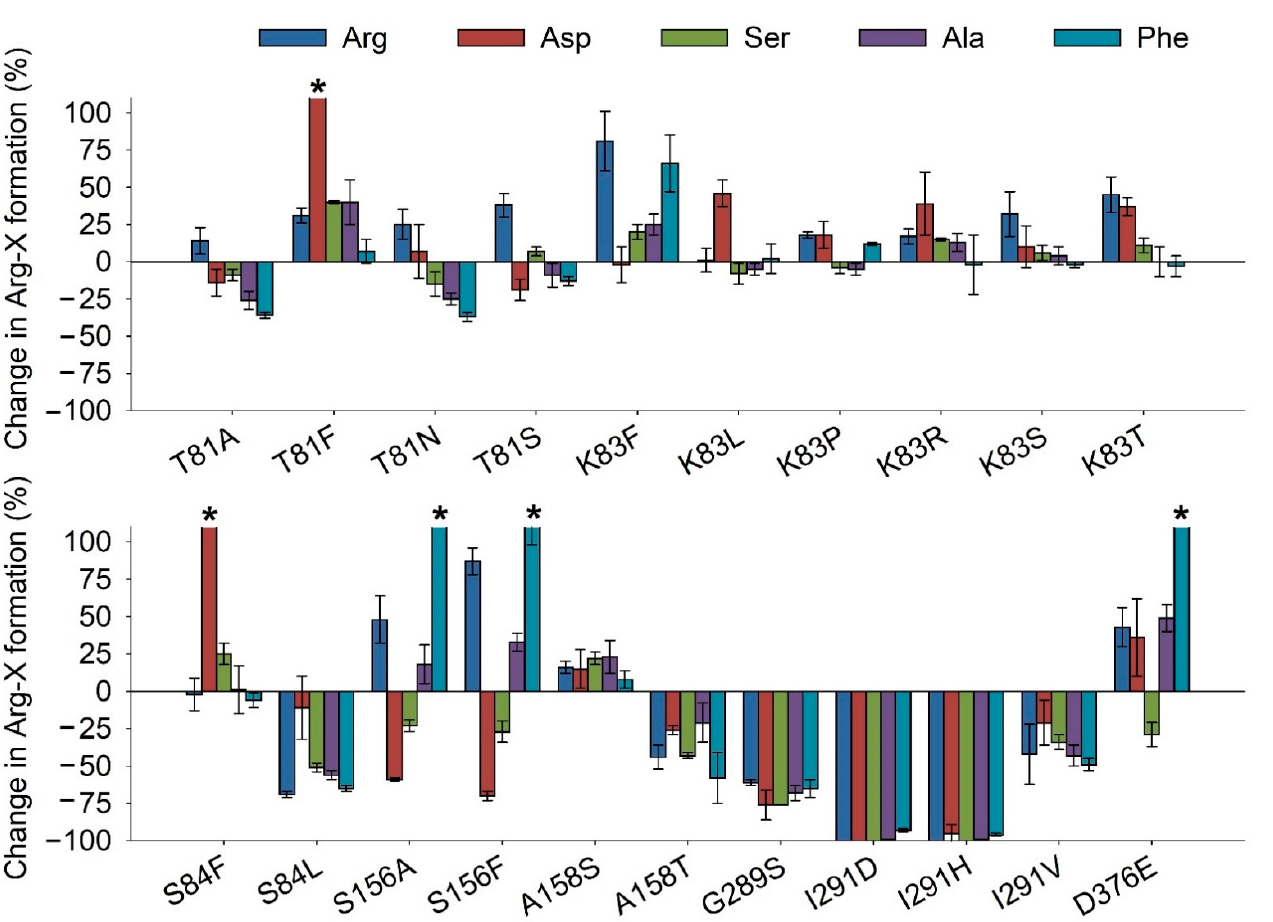
Figure 9. Change in product formation with RizA variants compared to the wild type with each substrate. * Values over 100% were truncated: T81F with Asp: 150 ± 26%; S84F with Asp: 155 ± 31%; S156A with Phe: 270 ± 22%; S156F with Phe: 123 ± 25%; D376E with Phe: 138 ± 11% (see Figure S3 for graph without truncation).